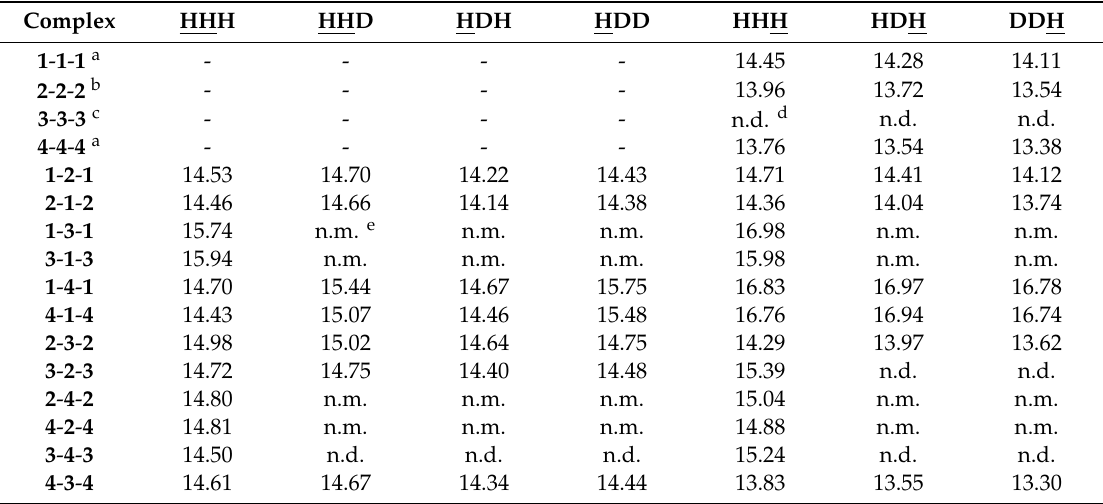
Table 2. The 1 H-NMR chemical shifts of bridging protons in various isotopologs of homotrimers and heterotrimers of POOH-containing acids 1 – 4 in CDF 3 / CDF 2 Cl at 100 K. The corresponding spectra are